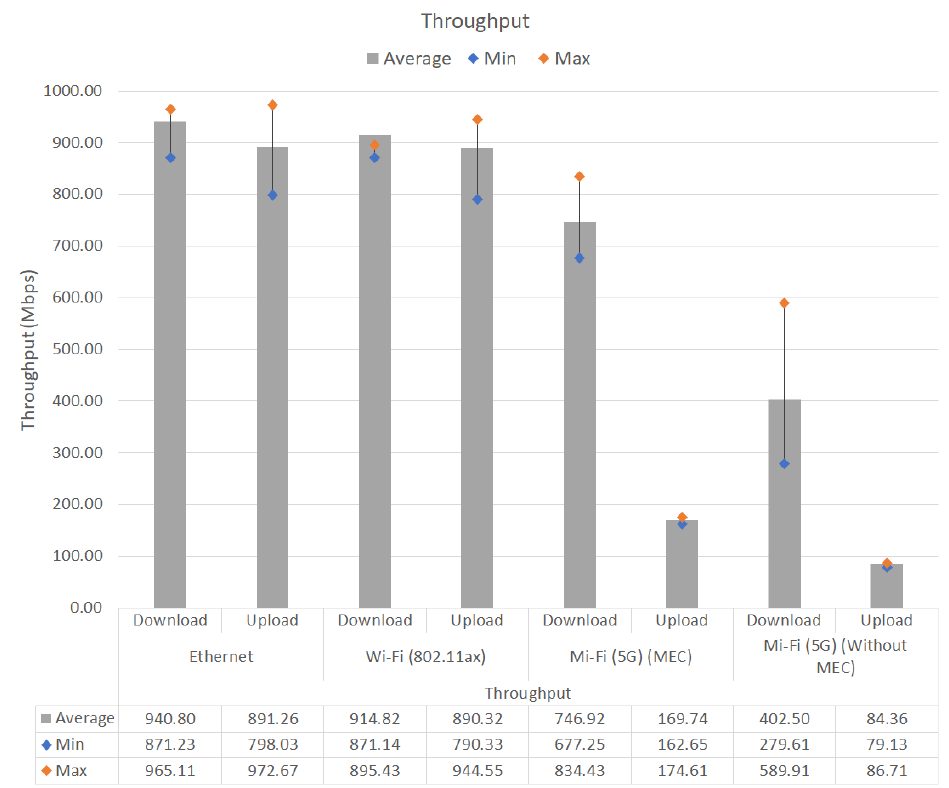
Figure 7. Multi-Access Edge Network Latency.